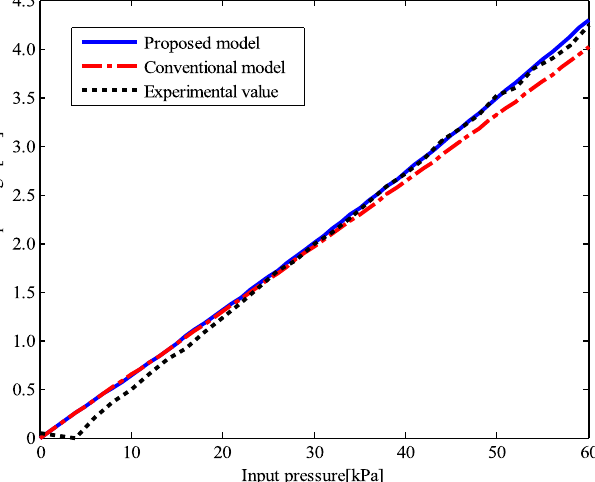
Figure 5. The comparison of proposed model and previous